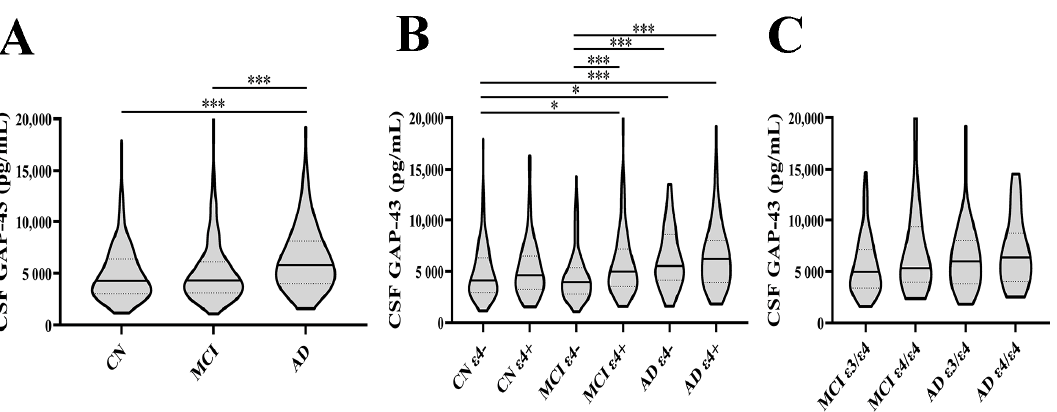
Figure 1. Differences in CSF GAP-43 levels among CN, MCI, and AD groups were tested using Kruskal–Wallis test ( A ). Differences in CSF GAP-43 levels among CN ε 4 − , CN ε 4+, MCI ε 4 − , MCI ε 4+, AD ε 4 − and AD ε 4+ groups were evaluated using the Kruskal–Wallis test ( B ). Differences in CSF GAP-43 levels between MCI ε 3/ ε 4 and MCI ε 4/ ε 4 groups, as well as between AD ε 3/ ε 4 and AD ε 4/ ε 4 groups were assessed using the Mann–Whitney U test ( C ). *: p < 0.05; ***: p < 0.001. CSF: cere- brospinal fluid; GAP-43: growth-associated protein 43; CN: cognitively normal; MCI: mild cognitive impairment; AD: Alzheimer’s disease.